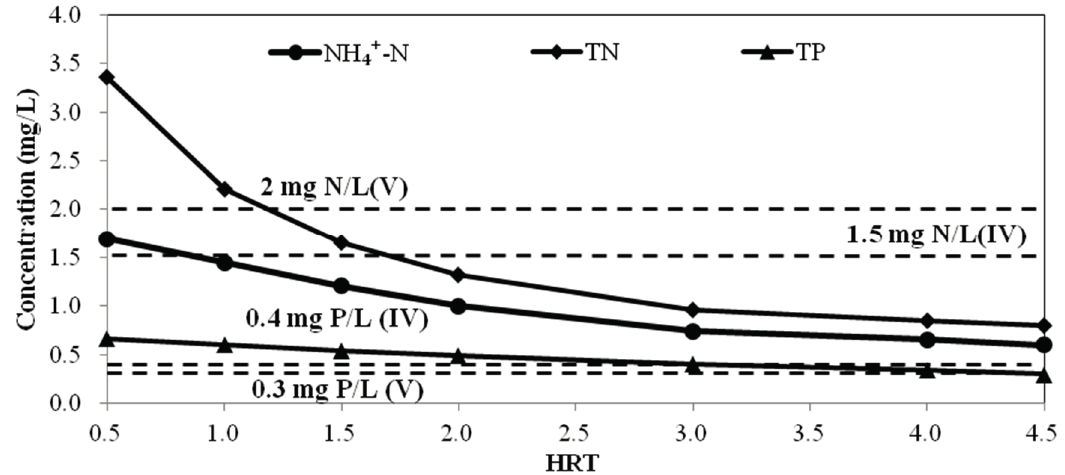
Figure 7. Relationship between effluent concentration and HRT. The dotted lines indicate Grade V and IV NH 4+ -N (2 mg/L, 1.5 mg/L), TN (2 mg/L, 1.5 mg/L) and TP (0.4 mg/L, 0.3